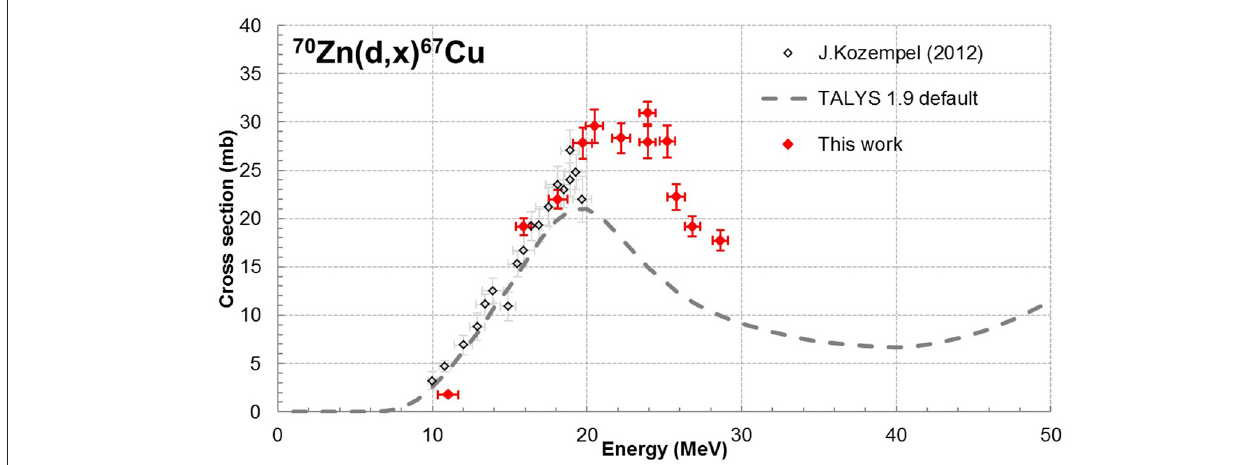
FIGURE 1 | Cross sections of reaction 70 Zn(d,x) 67 Cu ( 10).